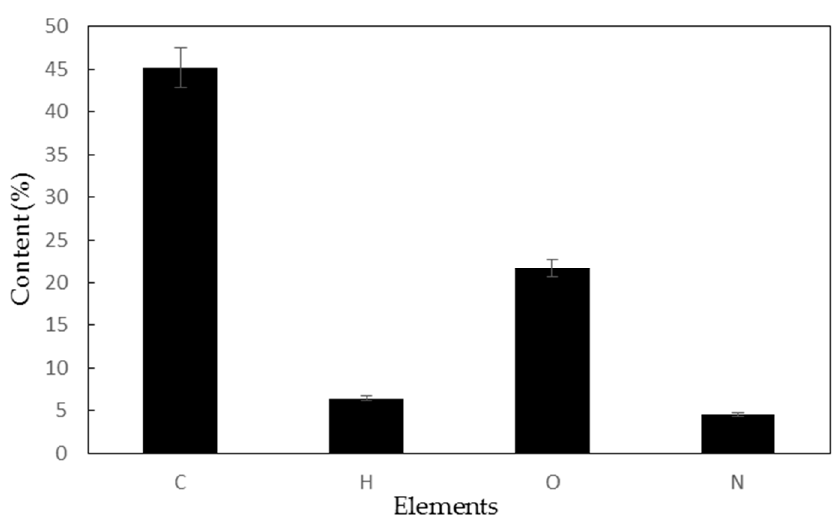
Figure 2. Contents of C, H, O, and N in Cq sludge samples.